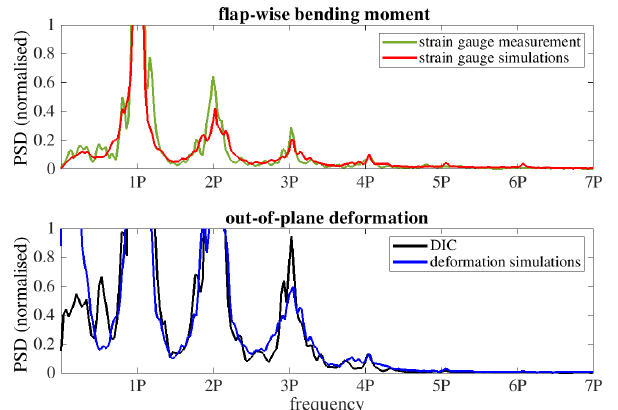
Figure 26. Coupling of rotor blade torsion and OoP deformation.